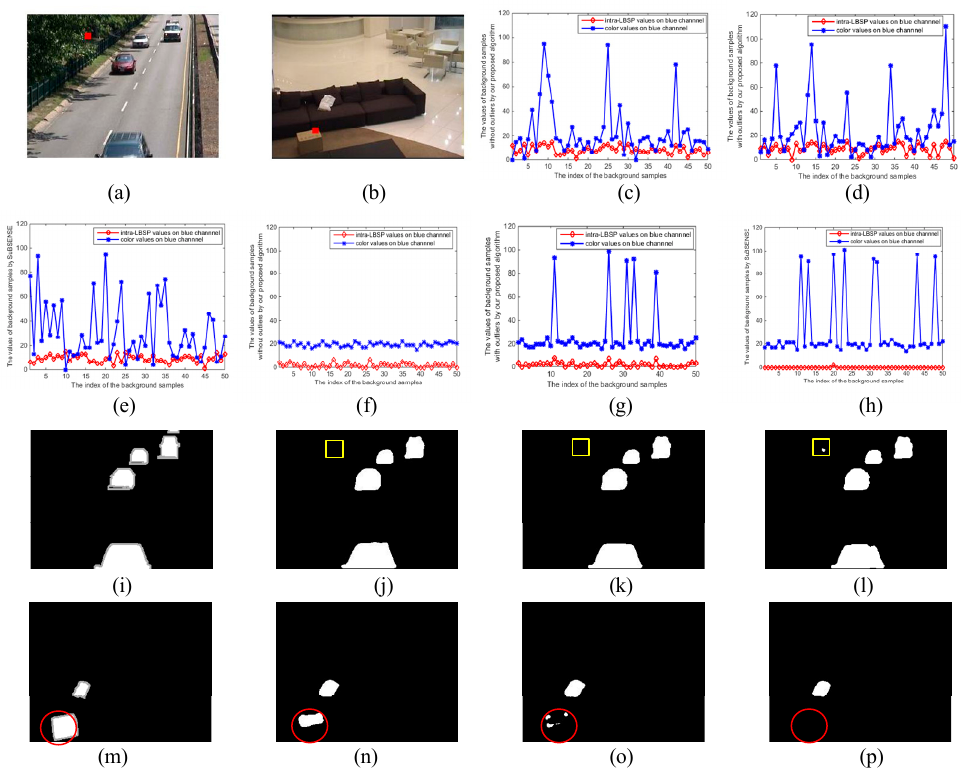
Figure 7. Comparison of background sample set between in static and dynamic regions. ( a ) Location of observed pixel (37, 102) on highway #001430. ( b ) Location of observed pixel (194, 73) on sofa #001030. ( c ) Background sample set obtained on (37, 102) by our proposed algorithm without outliers. ( d ) Background sample set obtained on (37, 102) by our proposed algorithm with outliers. ( e ) Background sample set obtained on (37, 102) by SuBSENSE. ( f ) Background sample set obtained on (194, 73) by our proposed algorithm without outliers. ( g ) Background sample set obtained on (194, 73) by our proposed algorithm with outliers. ( h ) Background sample set obtained on (194, 73) by SuBSENSE. ( i ) Ground-truth masks of highway #001430. ( j ) Detection results of our proposed algorithm without outliers on highway #001430. ( k ) Detection results of proposed algorithm with outliers on highway #001430. ( l ) Detection results of SuBSENSE on highway #001430. ( m ) Ground-truth masks of sofa #001030. ( n ) Detection results of our proposed algorithm without outliers on sofa #001030. ( o ) Detection results of proposed algorithm with outliers on sofa #001030. ( p ) Detection results of SuBSENSE on sofa #001030. Table 1. MSE comparison of color and LBSP feature in background sample set on three methods.